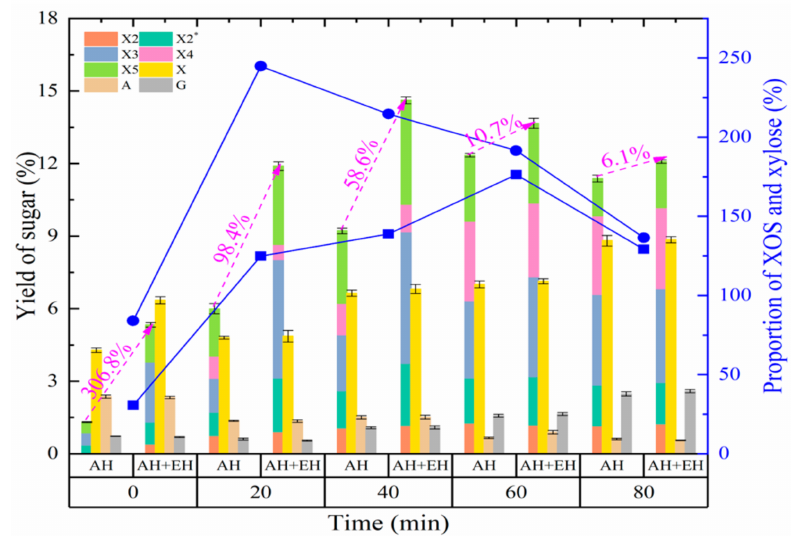
Figure 2. Effects of autohydrolysis pretreatments on sugar yield and the proportion of XOS and xylose over time. AH, autohydrolysis only treatment, no enzymatic hydrolysis treatment; AH + EH, autohydrolysis plus enzymatic hydrolysis treatment. Squares and solid line, the proportion of XOS and xylose for the autohydrolysis-only treatment; circles and solid line, the proportion of XOS and xylose for the autohydrolysis plus enzymatic hydrolysis treatment. The magenta text is the percentage increase in the yield of XOS after autohydrolysis treatment plus enzymatic hydrolysis treatment compared with that of the autohydrolysis-only treatment at different pretreatment times. X2, xylobiose; X2*, an oligosaccharide with a degree of polymerization between X2 and X3; X3, xylotriose; X4, xylotetraose; X5, xylopentaose; X, xylose; A, arabinose; G,